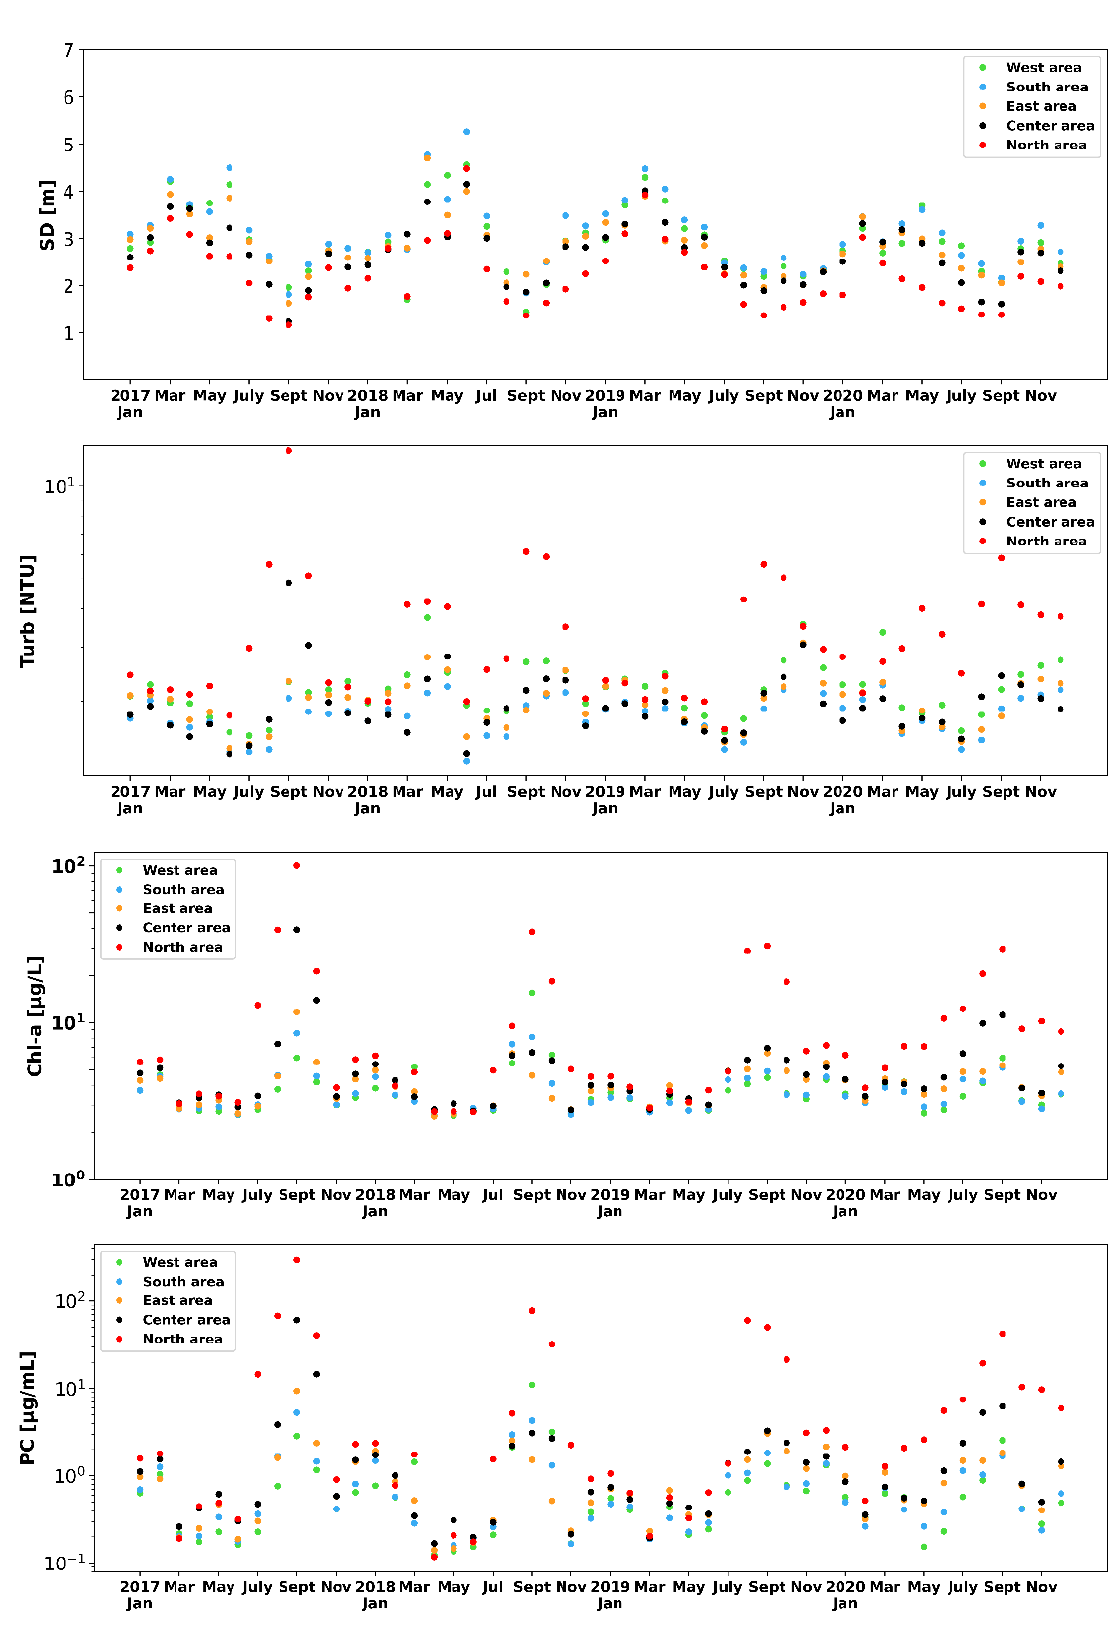
Figure 13. Monthly average for each of the areas and in the four water quality parameters analyzed in the period 2017 – 2020.